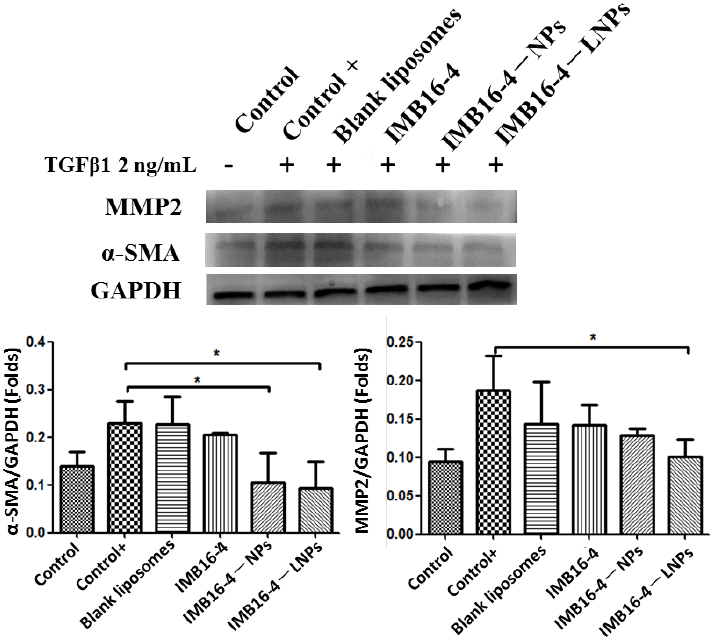
Figure 6. Western blot analysis of MMP2 and α -SMA expression in LX-2 cells. LX-2 cells were treated with 2 ng/mL TGF- β1 with or without 2 μM IMB16-4, IMB16-4–LNPs, and IMB16-4–NPs. The protein levels were normalized against GAPDH. The values are calculated by one way ANOVA following Dunnett’s test for comparison with TGF- β1 treatment group and expressed as the mean ± SD of triplicate independent assays. * p < 0.05, significantly different from TGF- β1 treatment